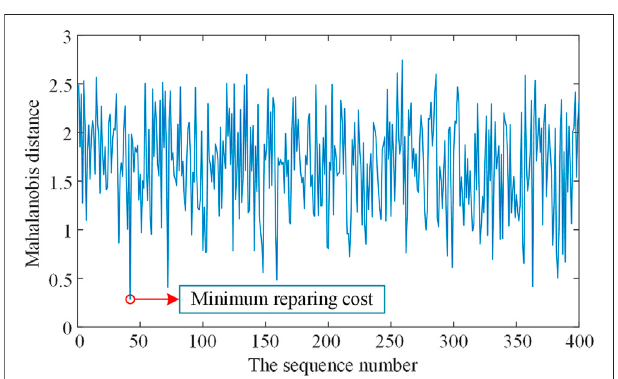
FIGURE 8 | The repairing cost of one